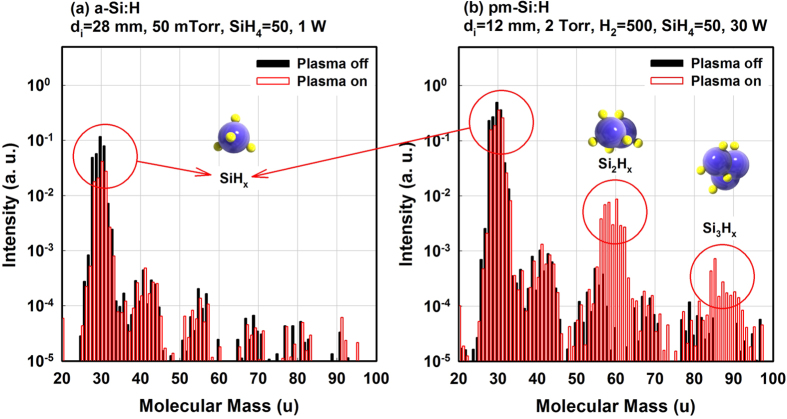
QMS scanned molecular mass distribution for (a) a-Si:H and (b) pm-Si:H deposition conditions at plasma on/off condition. Note that in pm-Si:H deposition conditions, higher-order silane species such as Si2Hx and Si3Hx are detected.